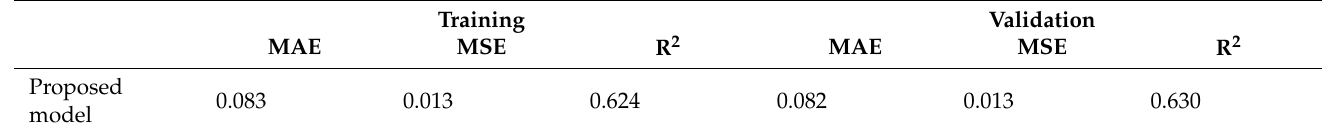
Table 6. Performance characteristics of the developed ANN-based predictive clothing insulation